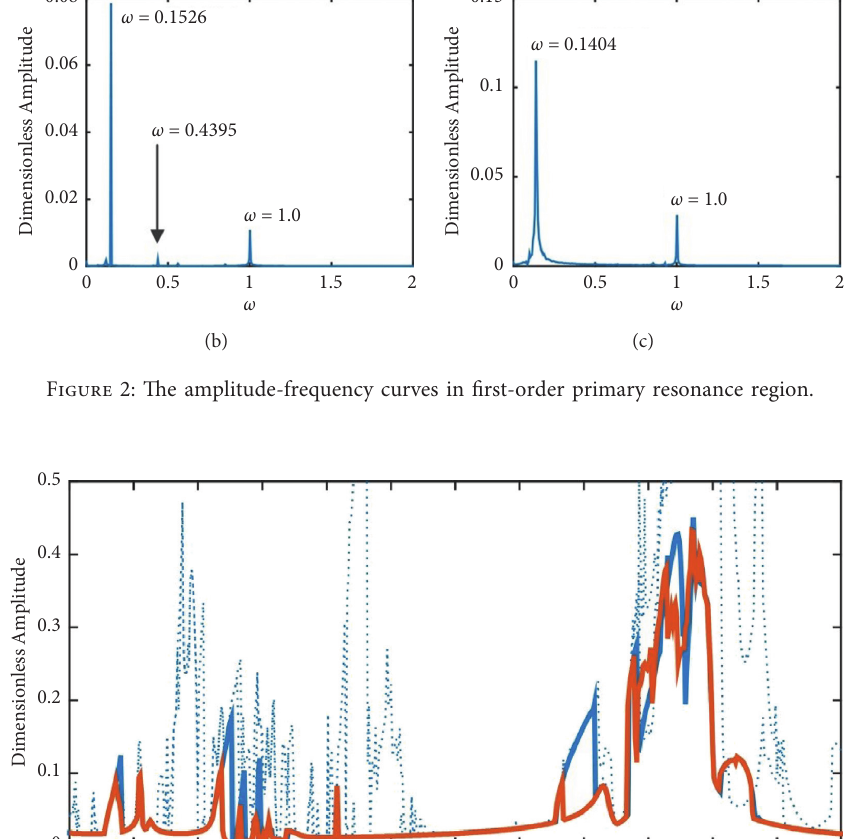
� 8. (a) Amplitude-frequency b